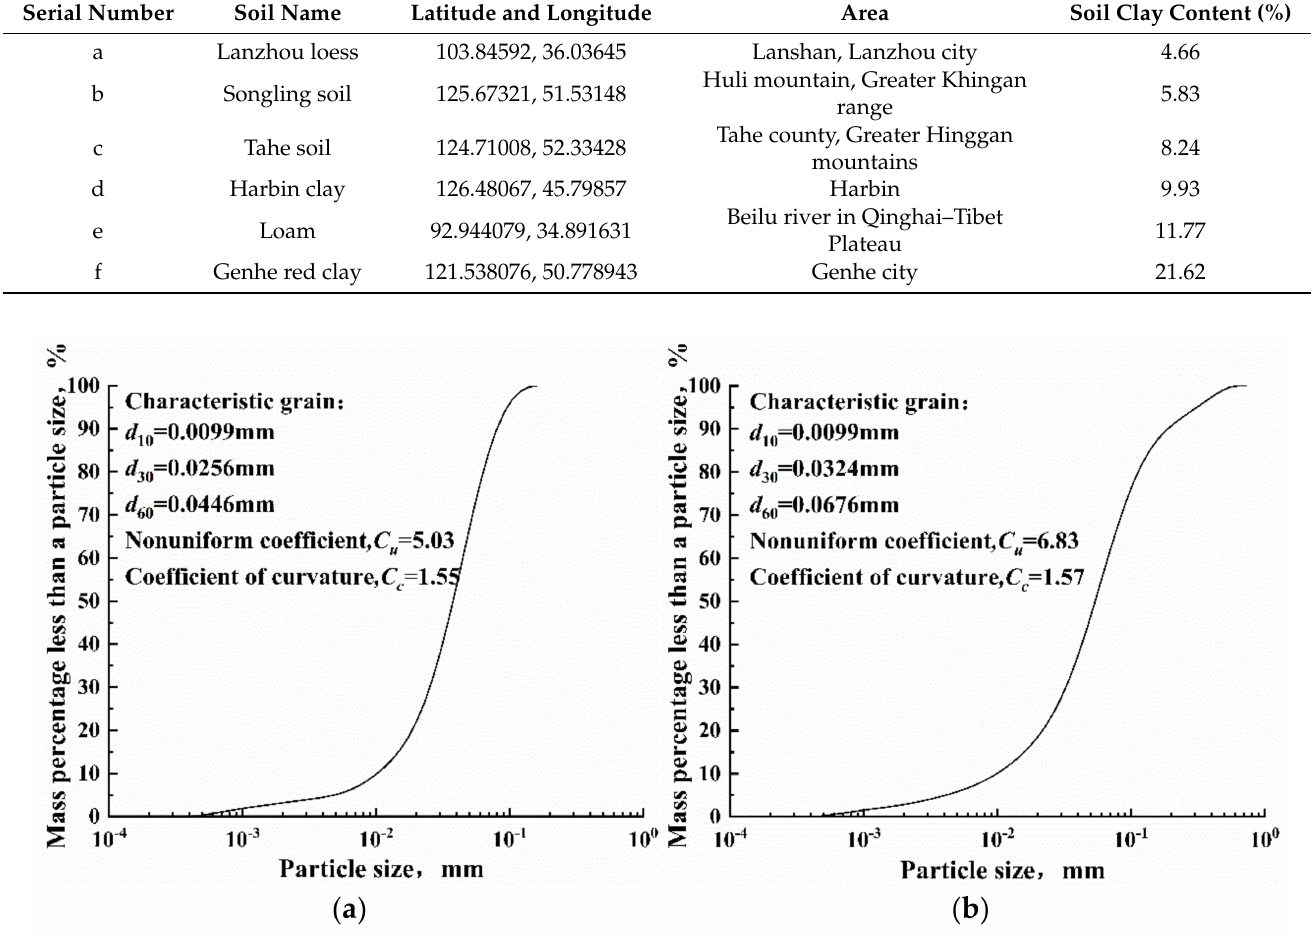
Table 1. Information and number of six soils.